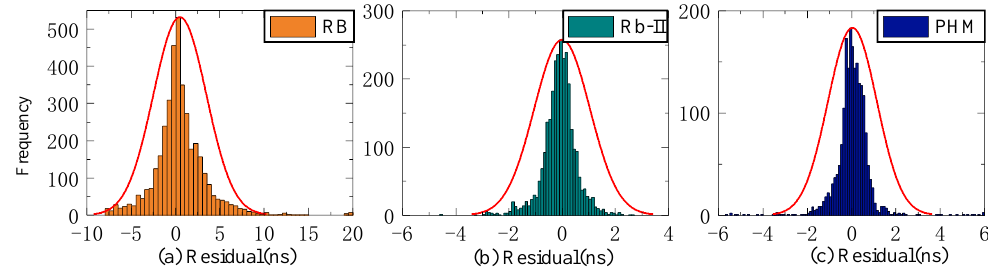
Figure 8. The ISUP-ISUO residuals of three atomic clocks. ( a ) The residual distribution of the RB clock. ( b ) The residual distribution of the Rb-II clock. ( c ) The residual distribution of the PHM clock.